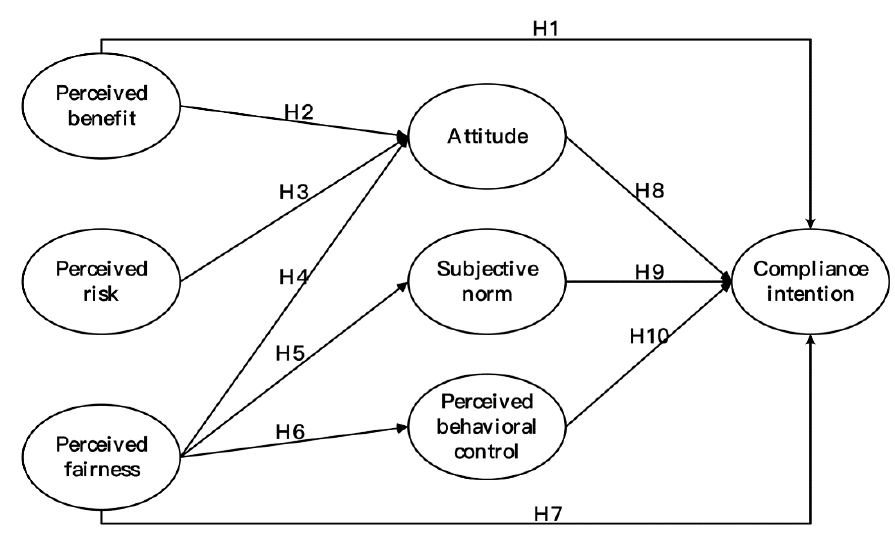
Figure 2. Research model.